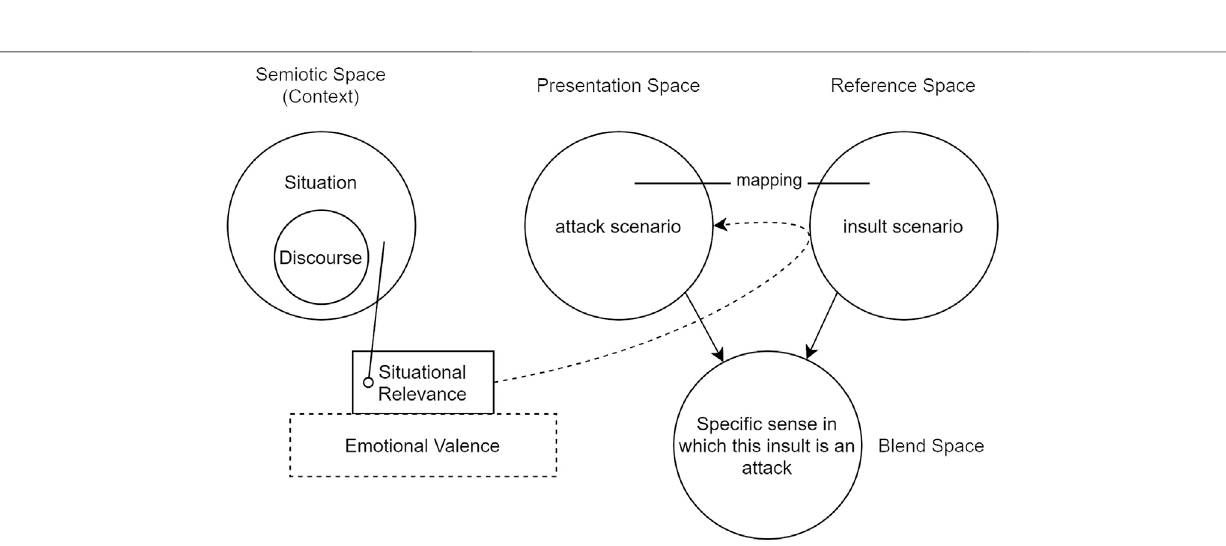
Frontiers in Robotics and AI |